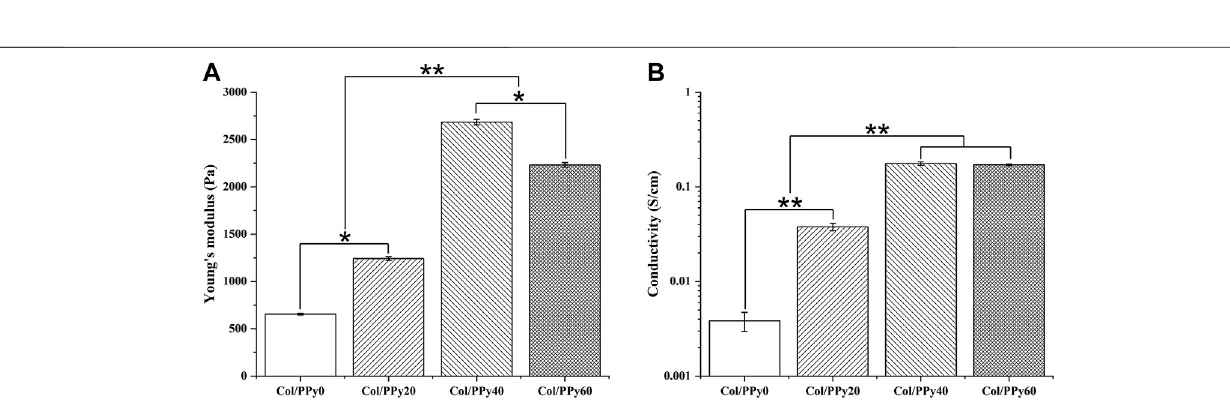
FIGURE 2 | (A) Young ’ s modulus and (B) conductivity of various Col/PPy